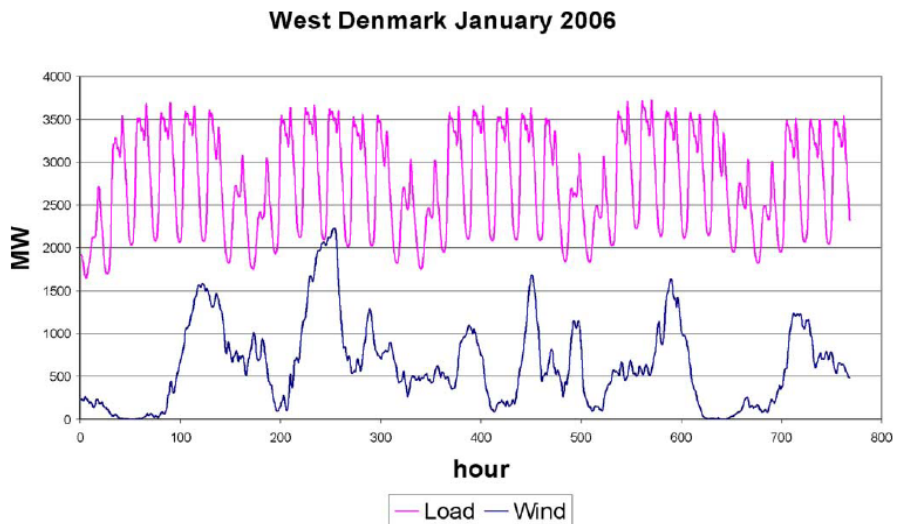
Figure 47. Wind power output and load in West Denmark (after